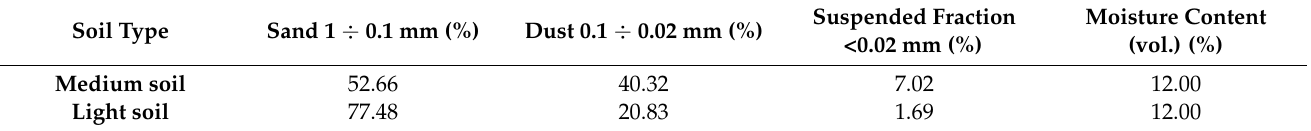
Figure 1. Test stand diagram: 1 —swingarm, 2 —specimen holder, 3 —bowl with abrasive mass ( 4 ), 5 —weight, 6 —specimen, 7 —moisture measure device. The particle size distribution of the soil masses is presented in Table 5. Table 5. Soil mass